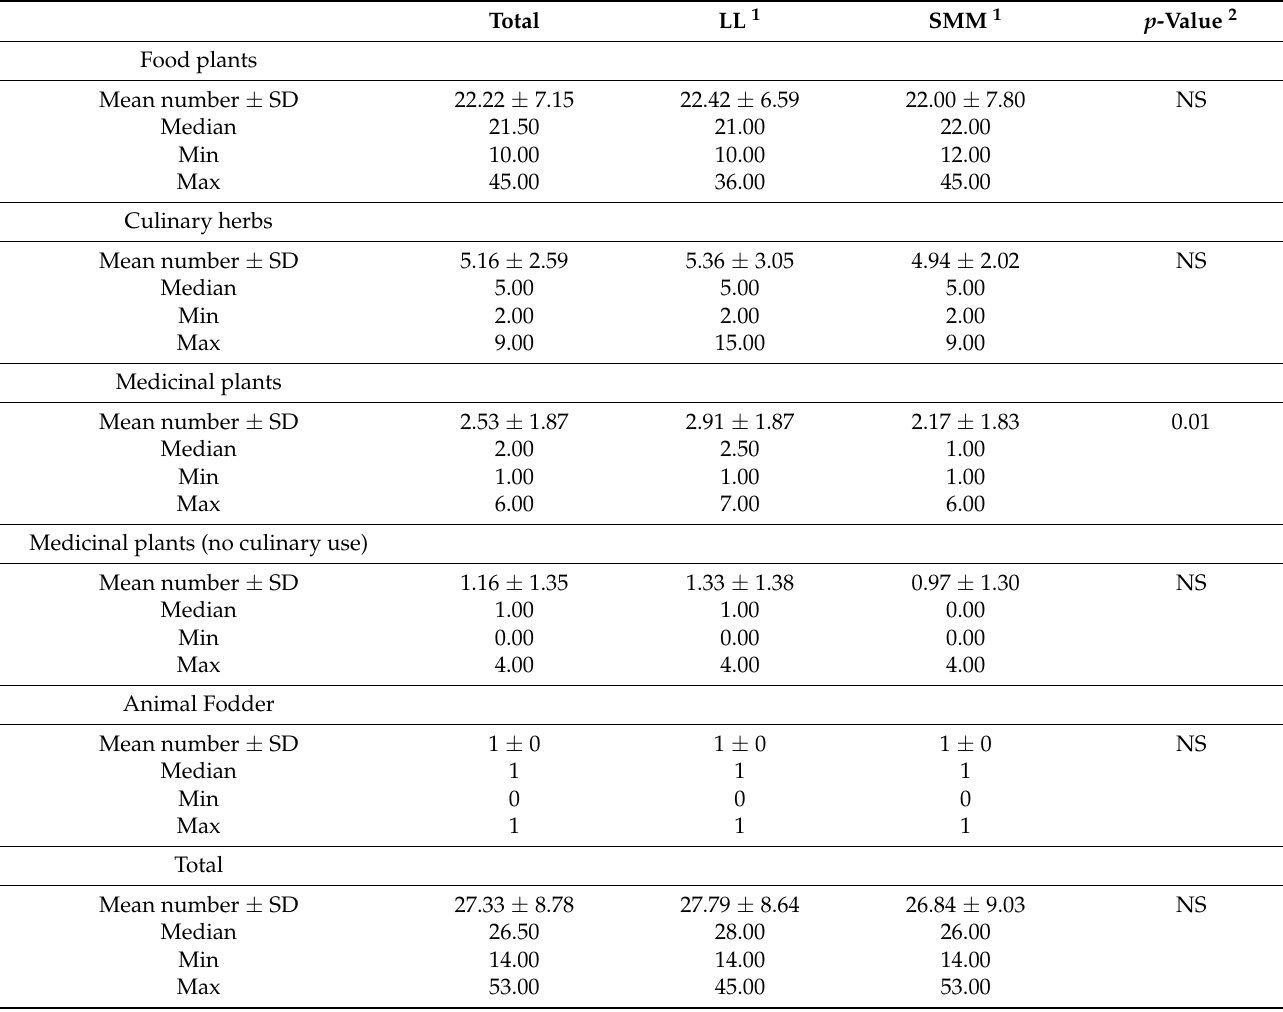
Table 2. Plant taxa used for food, medicinal plants or fodder cultivated in rural home gardens in Bulgaria. Total LL 1 SMM 1 p -Value 2 Food plants Mean number ±